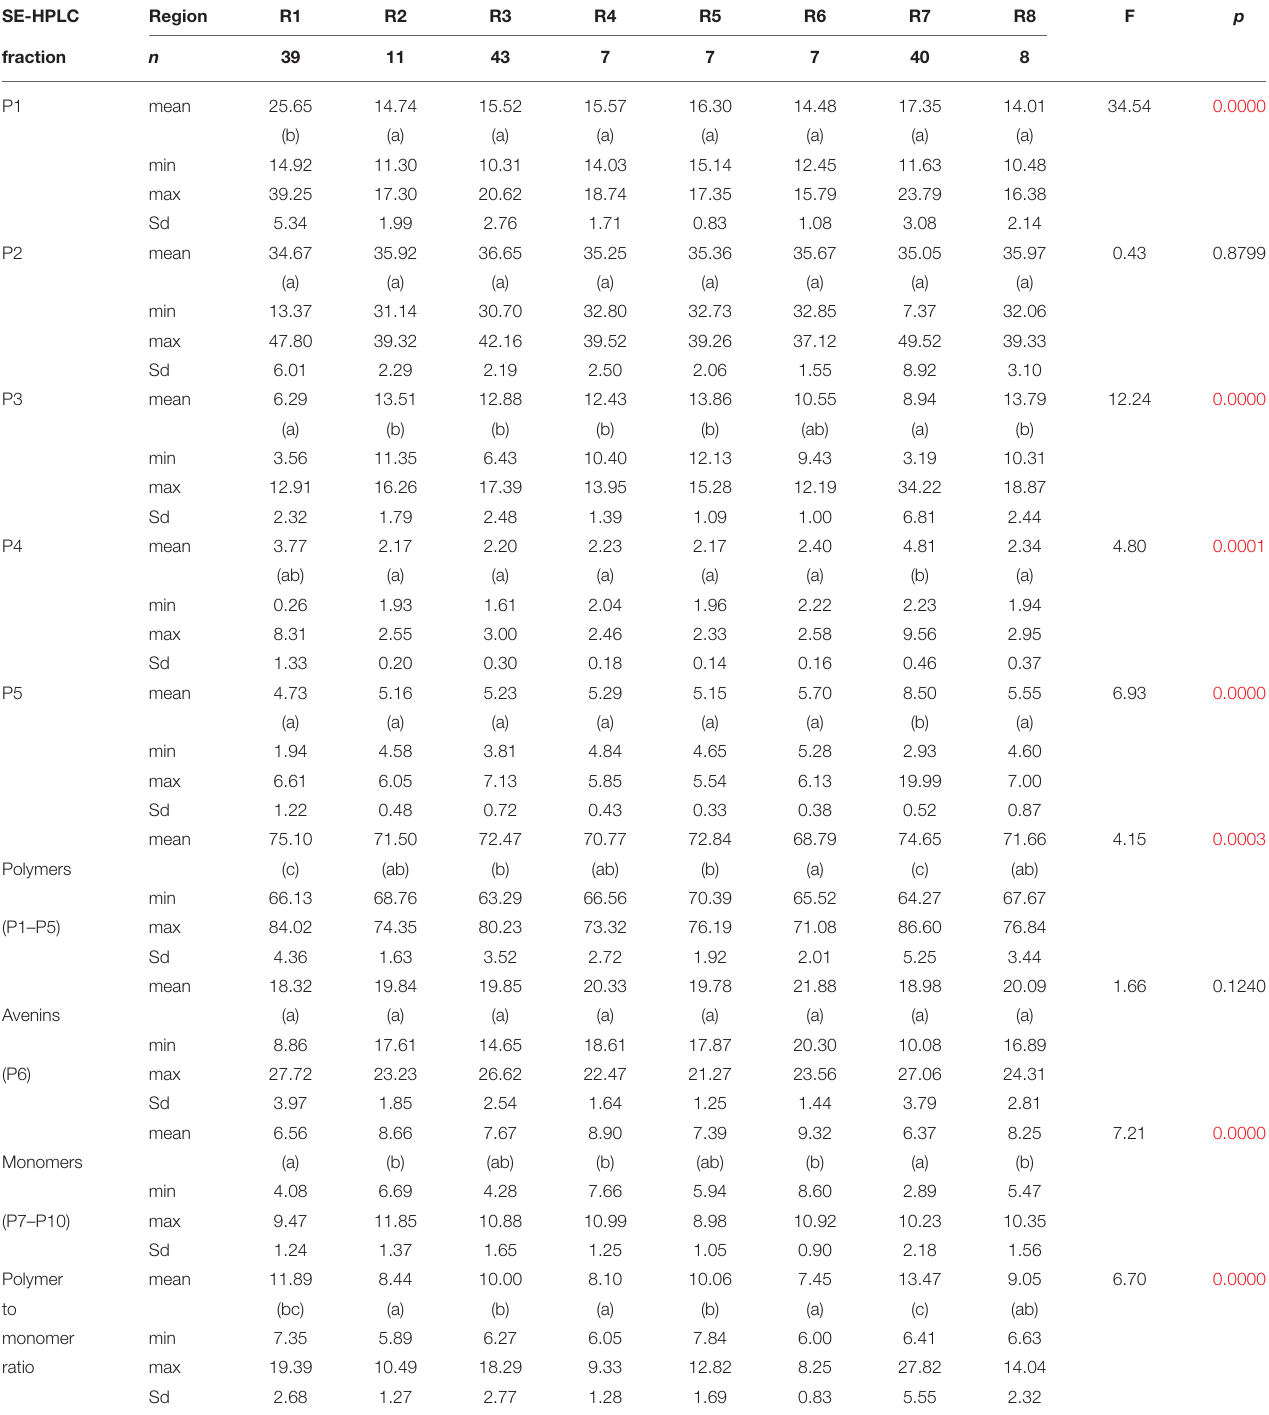
P values highlighted in red indicate significant differences among groups. Different letters indicate significantly different mean values based on Student t-test (p < 0.05).